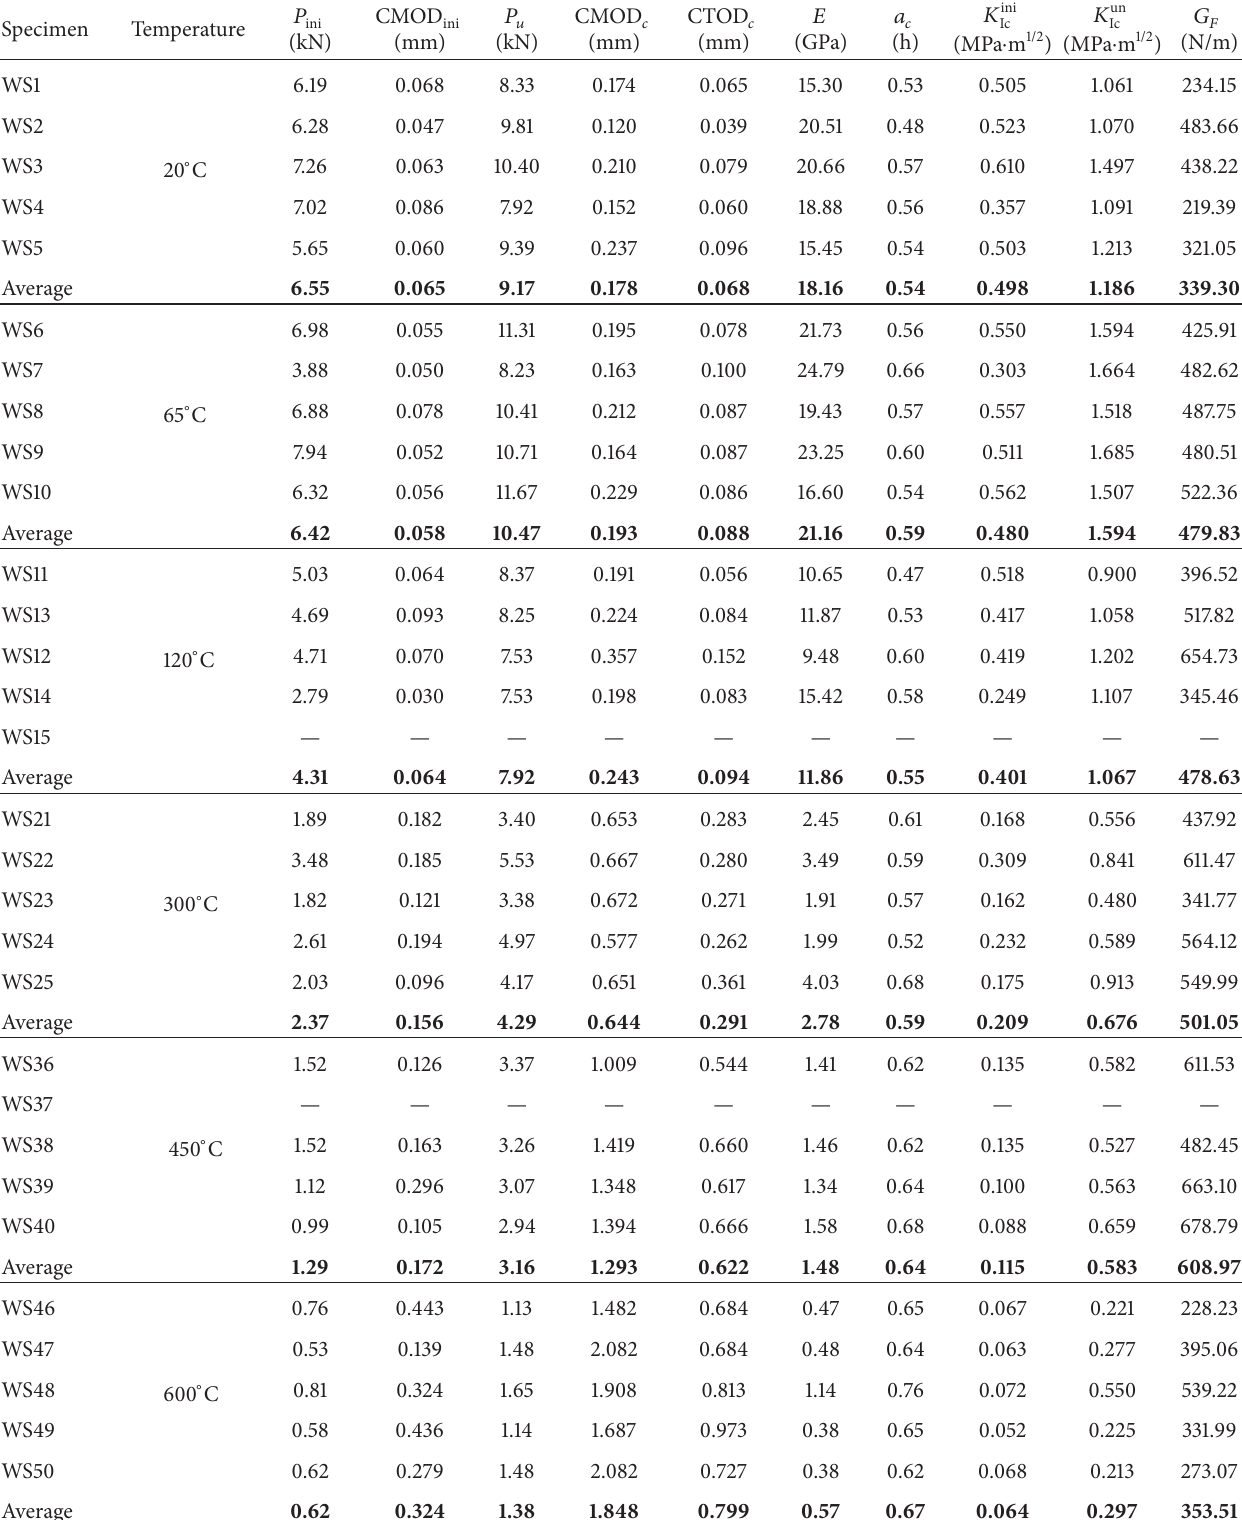
Table 1: Experimental results of fracture